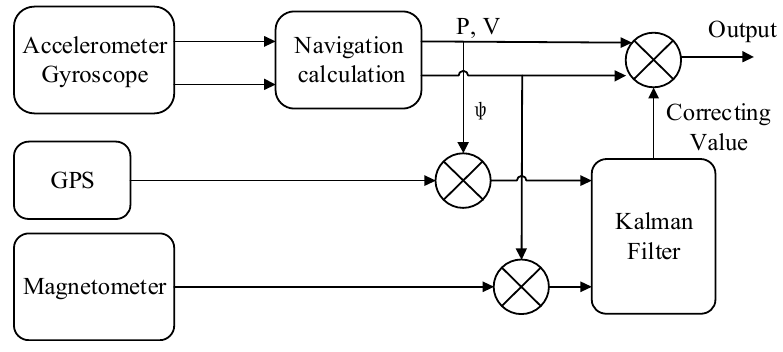
Figure 1. GNSS / IMU Outdoor Navigation